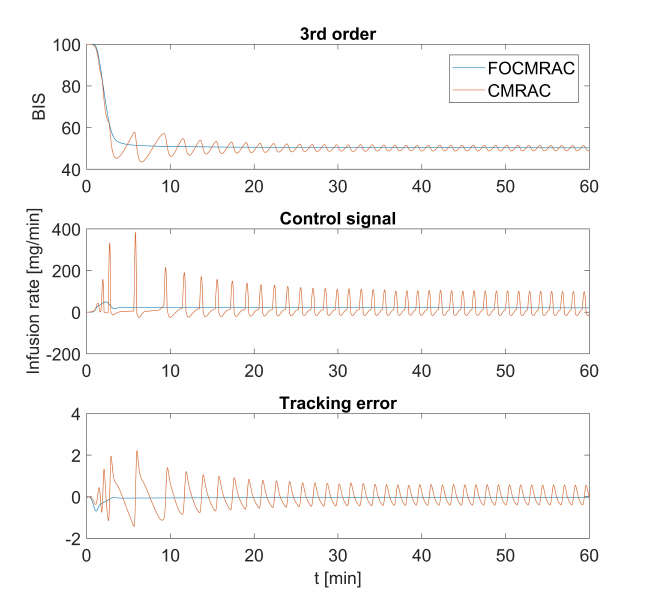
Figure 28. Comparison between the 3rd-order FOCMRAC and the CMRAC, BIS output, control signal, and tracking